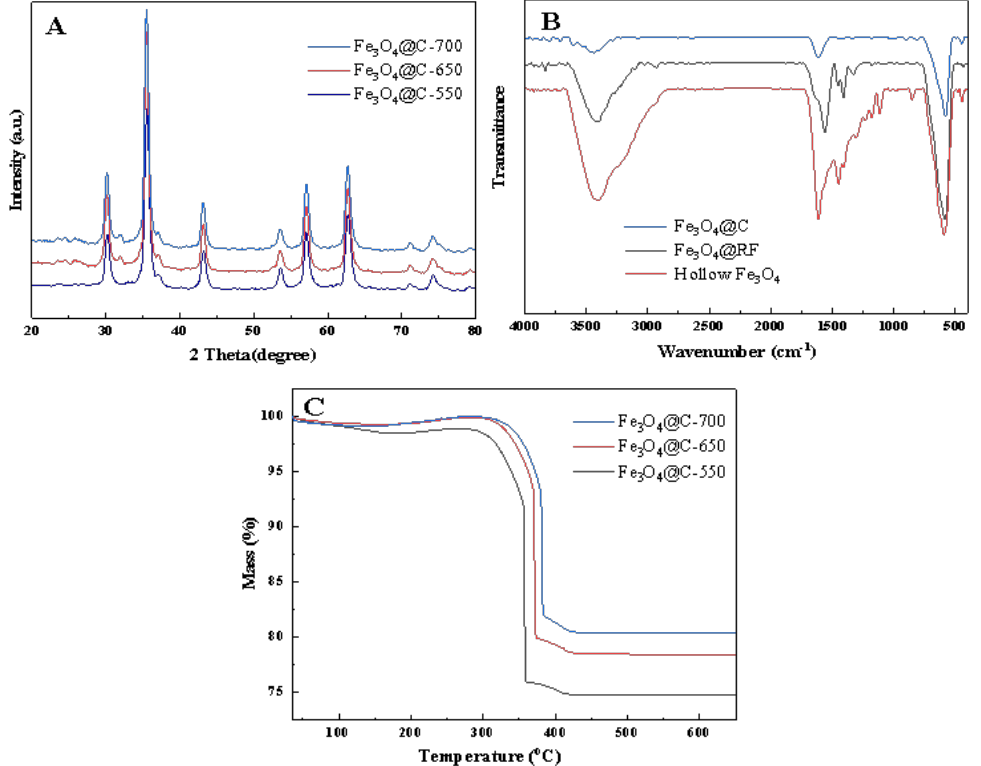
Figure 3. XRD ( A ), FTIR ( B ) and TGA ( C ) curves of Fe 3 O 4 @C microspheres prepared at different calcination temperatures.